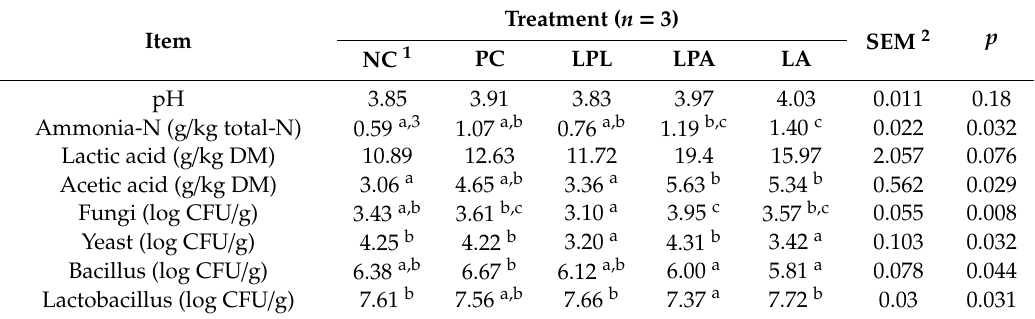
Table 2. Chemical and microbial analyses of maize silage extracts after 40 days of fermentation.